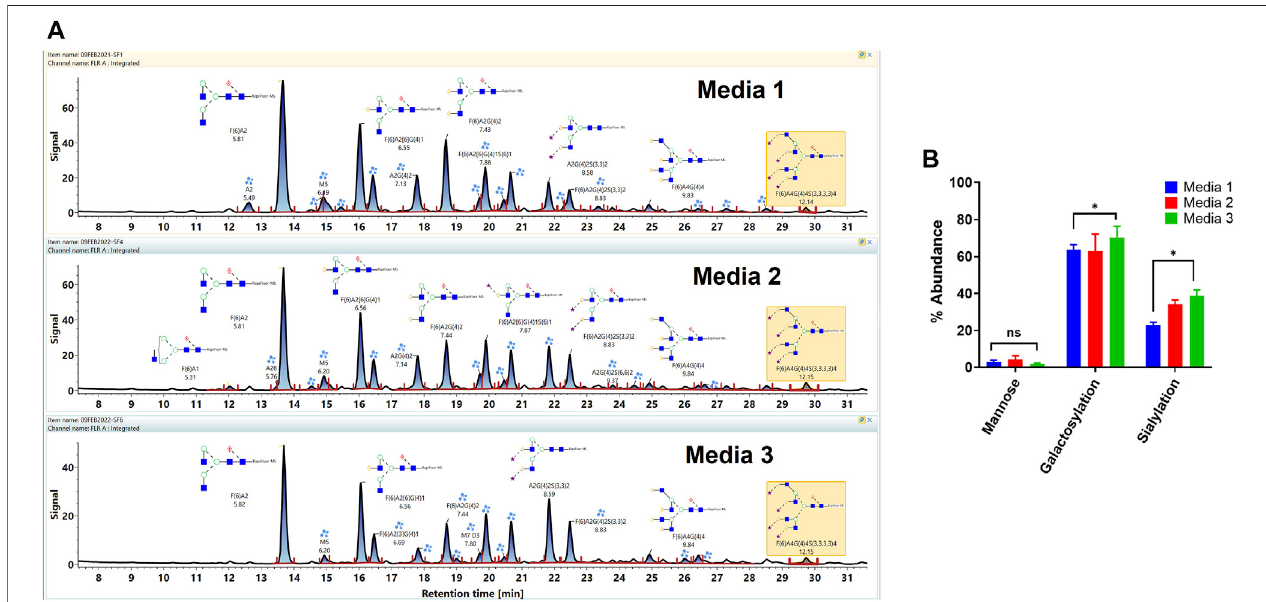
FIGURE 5 | (A) Released glycan map (FLR trace) of the VRC01 expressed using A11 clone in three different media. (B) Relative abundance of various glycan attributes of VRC01 grown in the three different media.